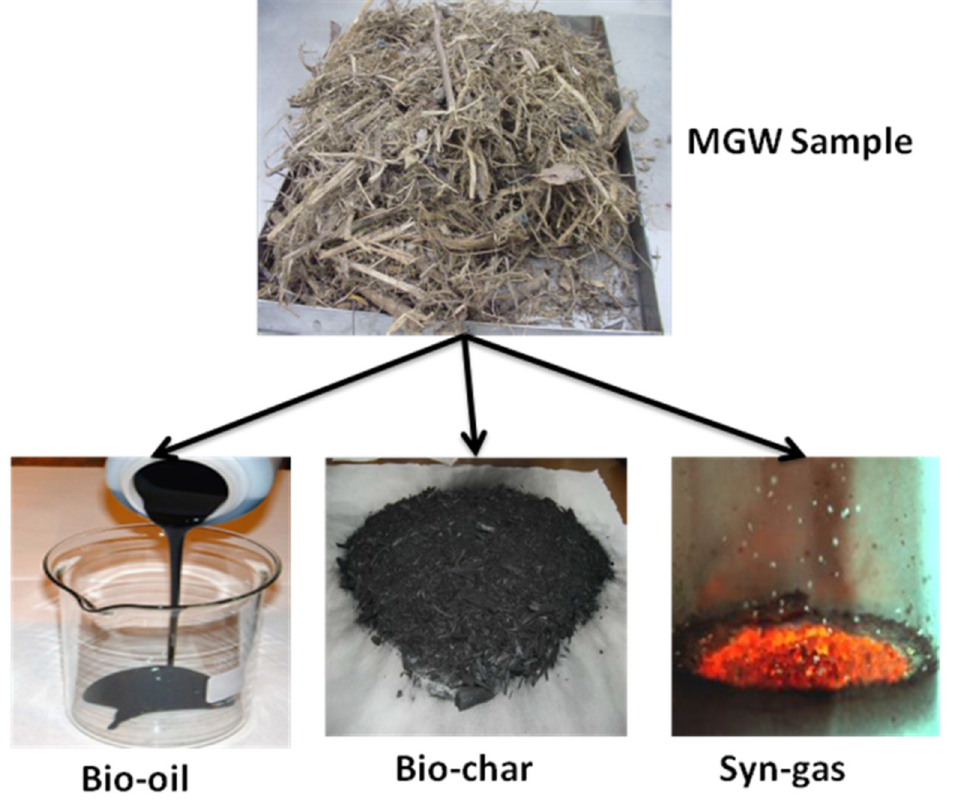
Figure 2. MGW Pyrolysis products (Bio-oil, Bio-char,